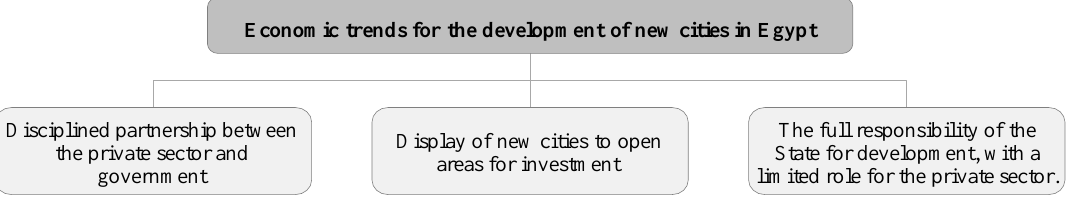
Figure 4: Illustrates the economic trends for the development of new cities in Egypt. Source: Eng. Mahmoud Amin. The Functional Roles of Cities and New Communities within the Framework of National and Regional Policies Comprehensive Urban Development. Published paper entitled: The International Congress of the policies of the New Urban Communities Development, Alexandria Library in